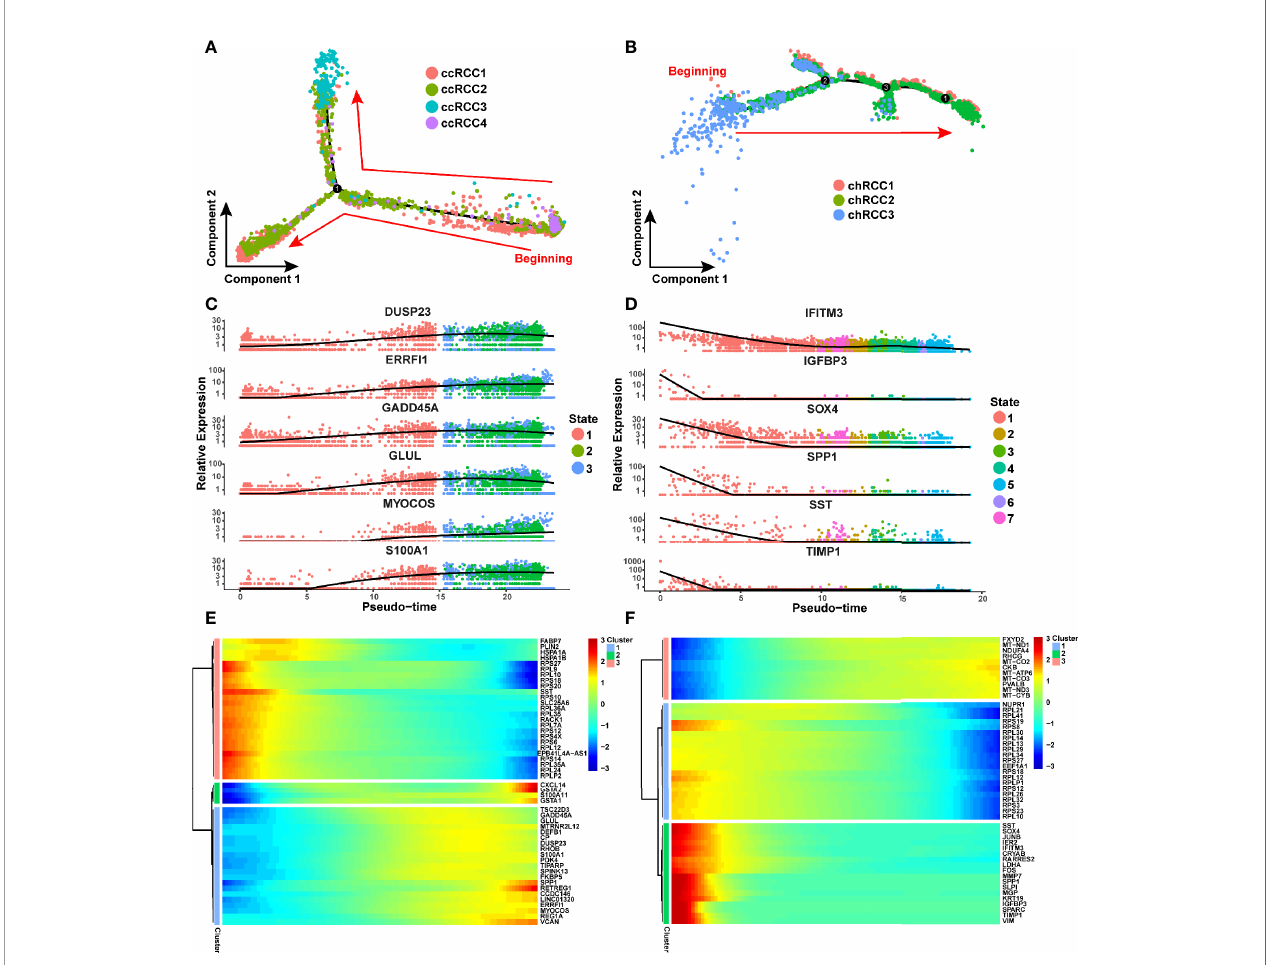
FIGURE 5 | CcRCC and chRCC development trajectories reconstructed using Monocle2. (A, B) Pseudo-time trajectories performed on ccRCC and chRCC tumor cells. Each dot stands for one cell and is colored in accordance to its cell type. The arrows represent the direction of cell evolution. (C) Scatter plots showing the expression levels and changes in relative expression of key genes that affected the evolution of ccRCC with pseudo-time. (D) Scatter plots showing the expression levels and changes in relative expression of key genes that affected the evolution of chRCC with pseudo-time. (E, F) Heatmap showing the top 50 genes that affected the evolution of ccRCC and chRCC cells along the